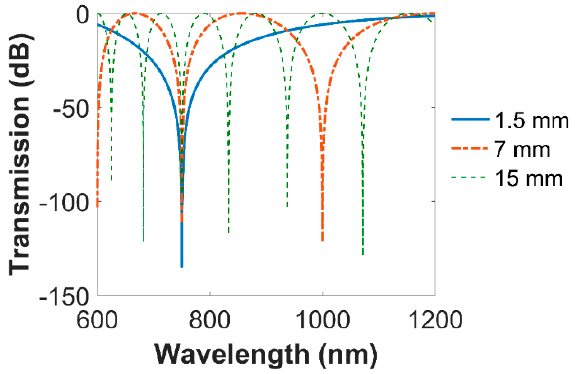
Figure 8. Transmission spectra of the Sagnac interferometer optical fiber sensor as a function of wavelength for different fiber lengths.